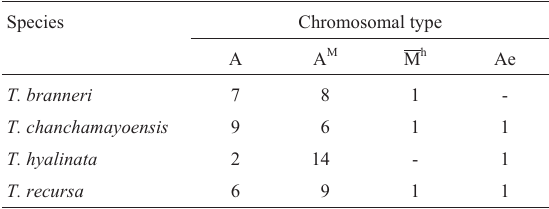
Table 1 - Chromosomal types in four species of Trigona based on the no- menclature proposed by Imai